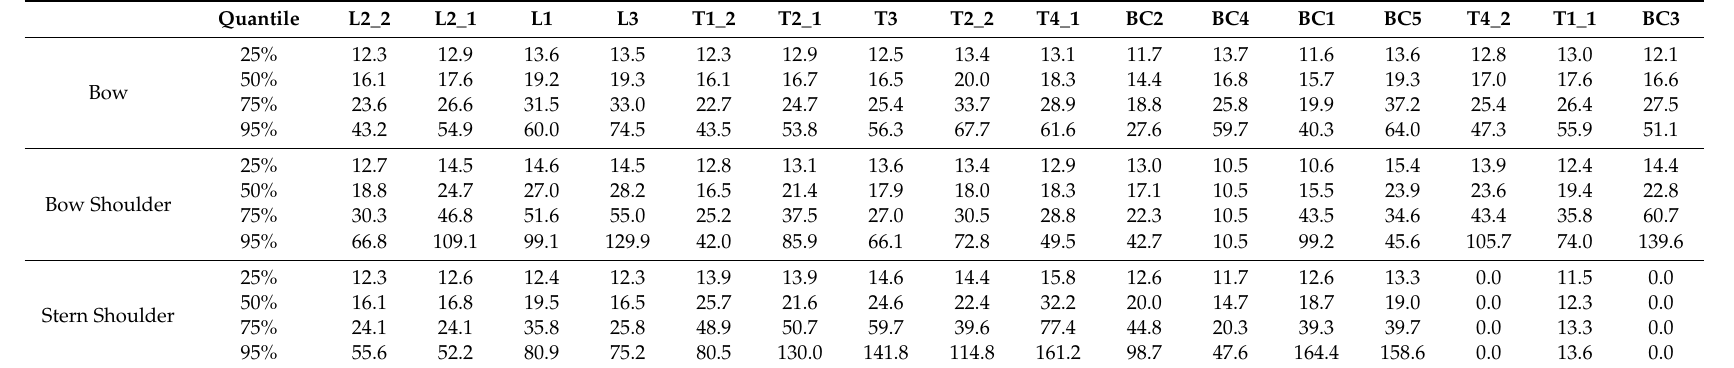
Table 9. The 25%, 50%, 75%, and 95% quantiles of measured ice-induced load magnitudes at bow, bow shoulder, and stern